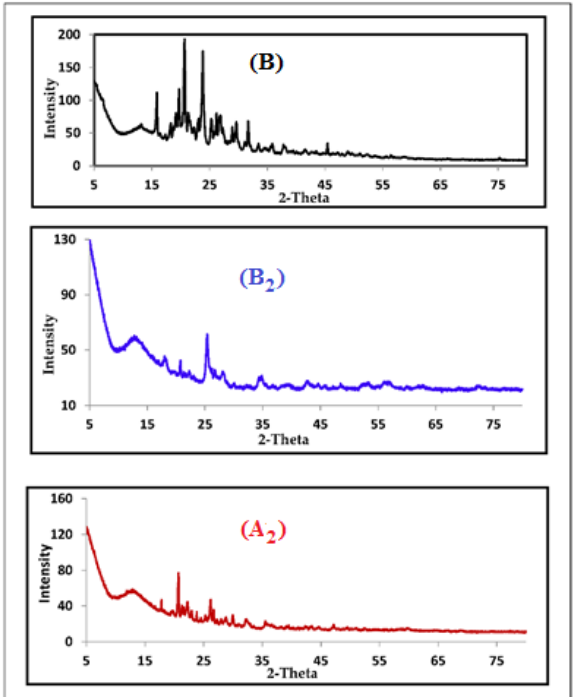
Figure 3. PXRD powder pattern of the ligand (B) and Mn(II) complex before (B, B 2 ) and after irradiation (A 2 ).